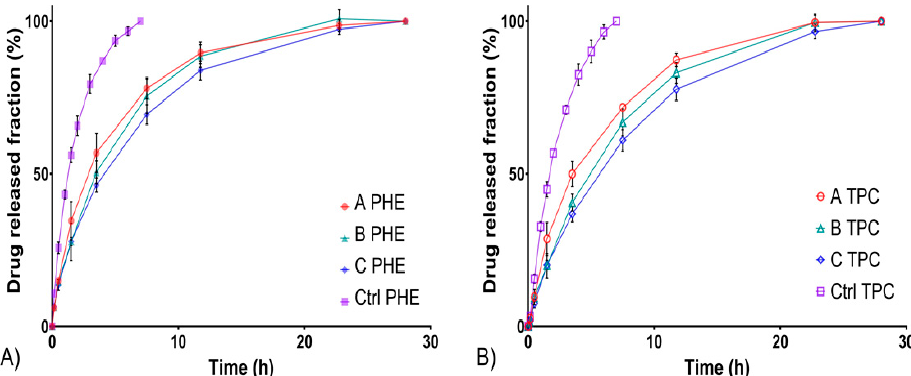
Figure 3. In vitro drug release profiles from formulations A, B, and C compared with a liquid control solution using the semi-solid adapter. PHE ( A ) and TPC ( B ) release profiles at 15 mL/min flow rate.